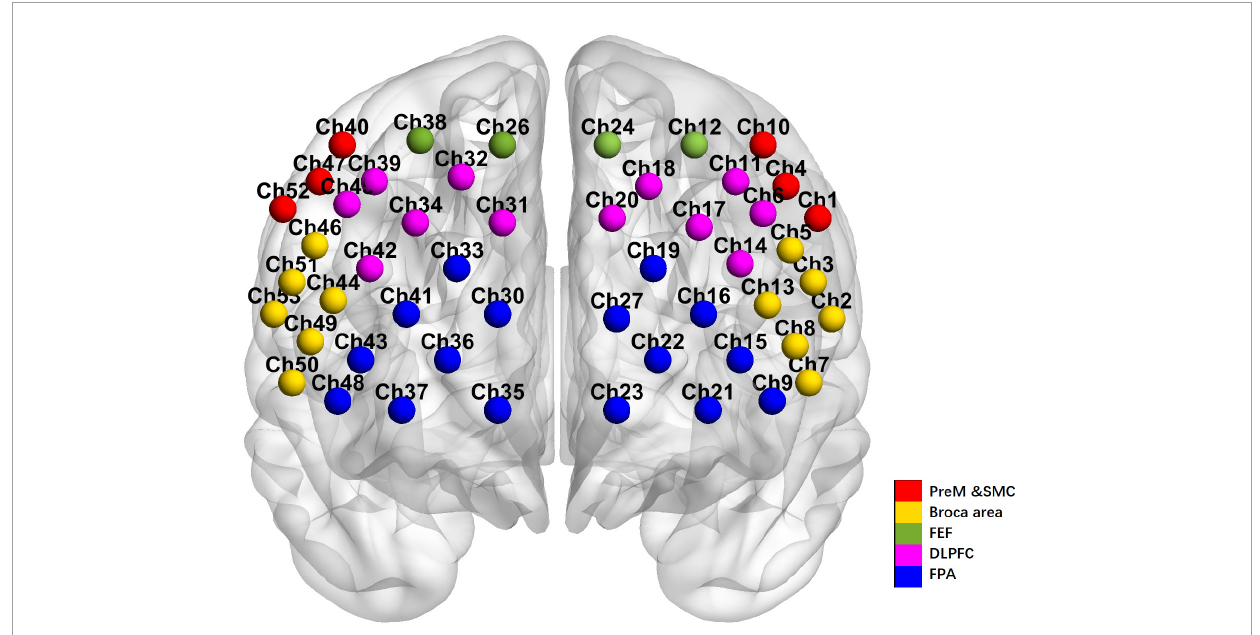
FIGURE1 The arrangement of channels of the 53-channel near-infrared spectroscopy system according to the Brodmann’s map of the cortex.